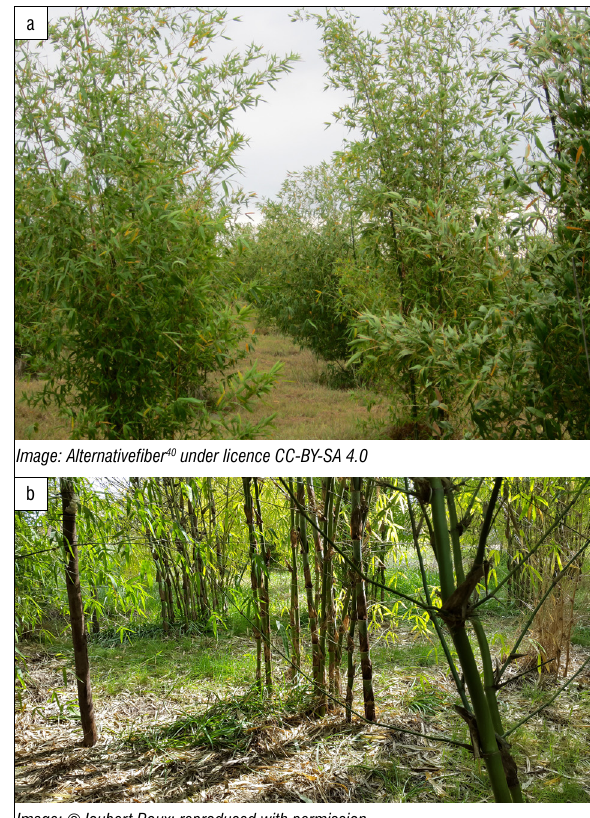
(a) Kowie Bamboo Farm, Bathurst, Eastern Cape, South Africa. (b) Lateral Project Solutions Bamboo Farm, Vredendal, Western Cape, South